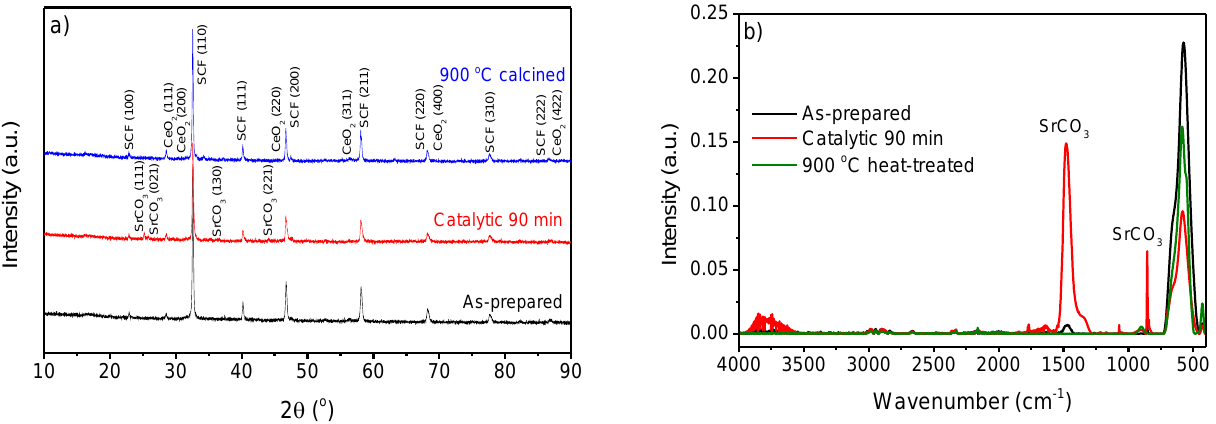
Figure 6. Structural characterization of as-prepared SCF, used as catalyst for BPA degradation at 60 °C for 90 min, and heat-treated at 900 °C for 1 h in air using ( a ) XRD and ( b ) ATR-FT-IR. The diffraction peaks are assigned based on the compound and the Miller index of SCF (Sr 0.85 Ce 0.15 FeO 3 )